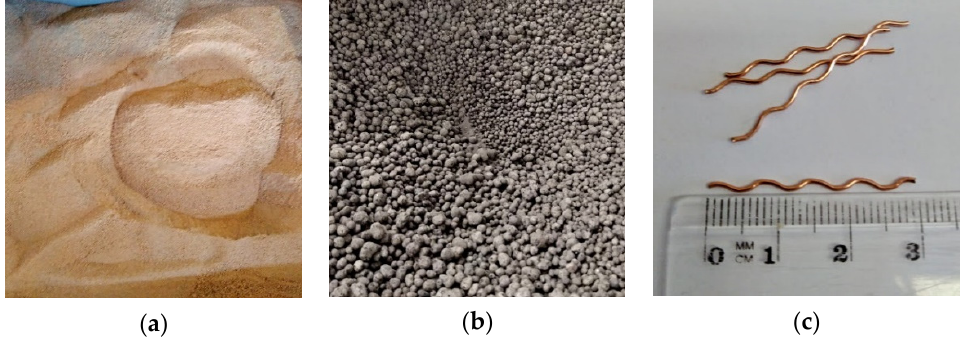
Figure 1. Waste red ceramic fine aggregate (WRCFA) ( a ), expanded clay coarse aggregate (ECCA) ( b ), copper-coated crimped (CCC) steel fibre ( c ).